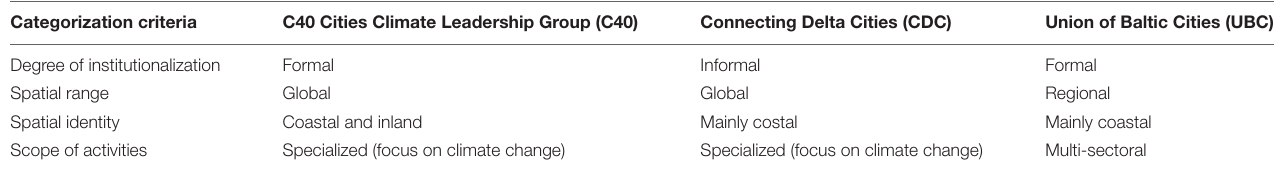
TABLE 1 | Overview of the analyzed networks.